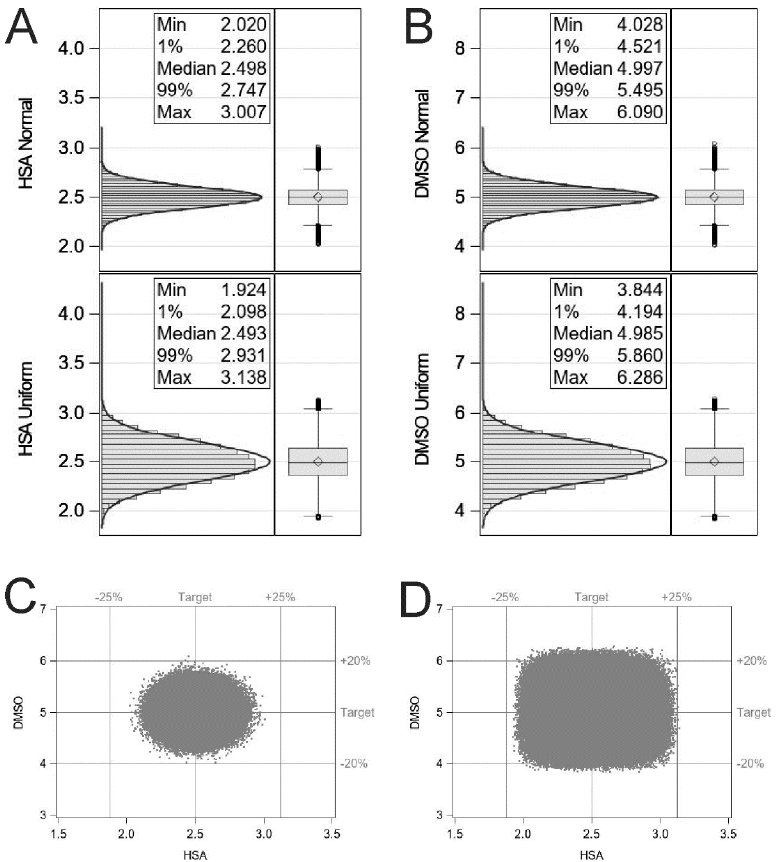
Figure 1. Histograms illustrating the effect of ±10% dispensing inaccuracy from either a normal distribution or uniform distribution for HSA ( A ) and DMSO ( B ). Scatter plots representing the Monte Carlo simulations for normal centred ( C ) and uniform ( D ) distributions. Statistical simulations were performed using the SAS System for Windows, release 9.4.